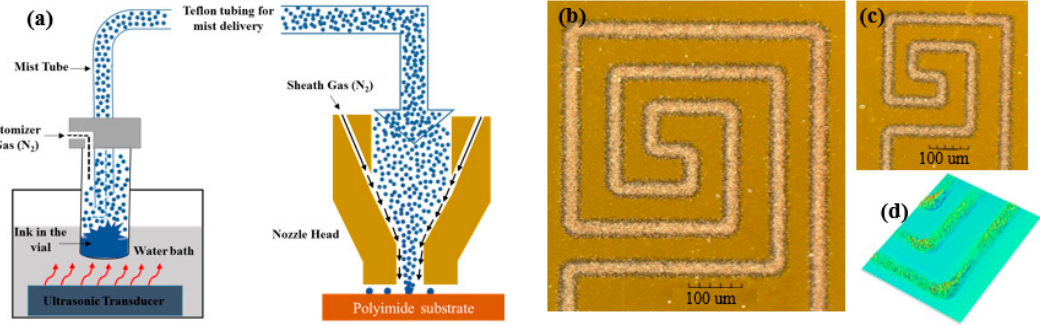
Figure 1. ( a ) Schematic of Ultrasonic Atomizer jet printing system; ( b ) Double meander micro-